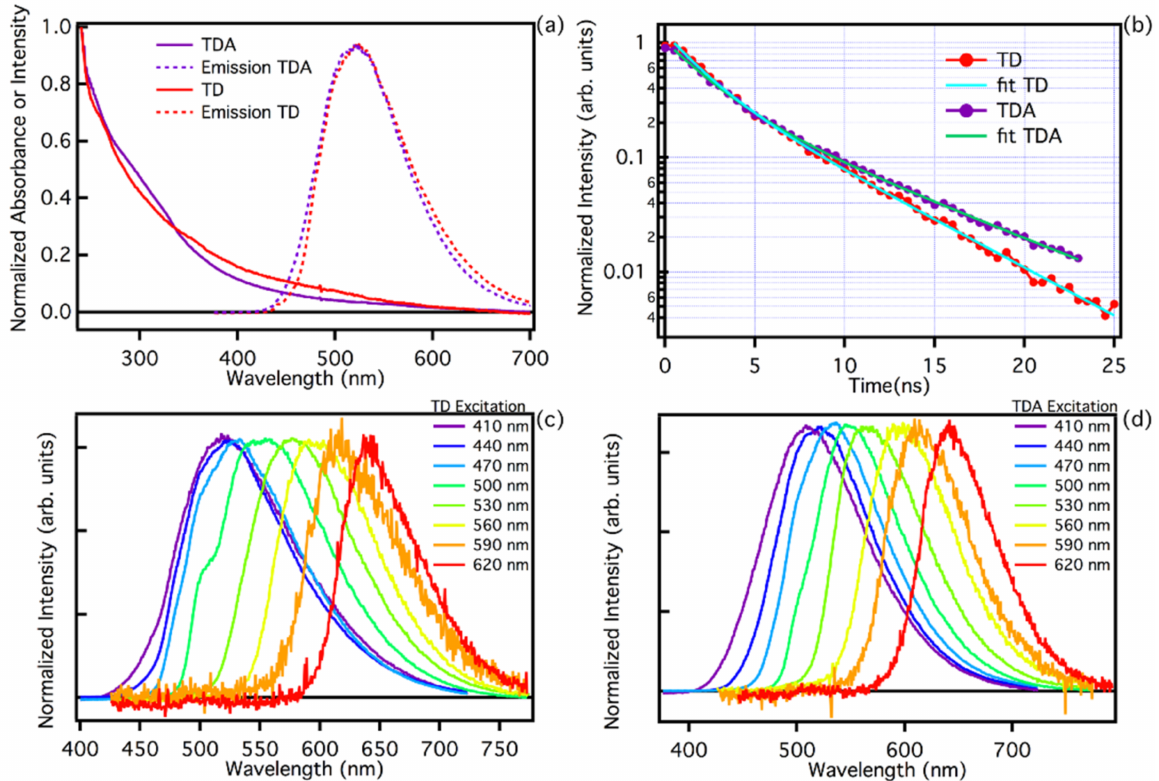
Figure 2. ( a ) Absorption spectra of TDA (purple line) and TD (red line) and emission spectra normalized to the maximum excited at the same wavelength of 440 nm. ( b ) Photoluminescence time decay at wavelength 520 nm, as collected by time-resolved fluorescence measurements on TDA (purple line) and TD (red line), excited at a wavelength of 440 nm ( c ) TD emission tunability normalized to the maximum as observed exciting the sample in the range 410–620 nm. ( d ) TDA emission tunability normalized to the maximum exciting the sample in the range 410–620